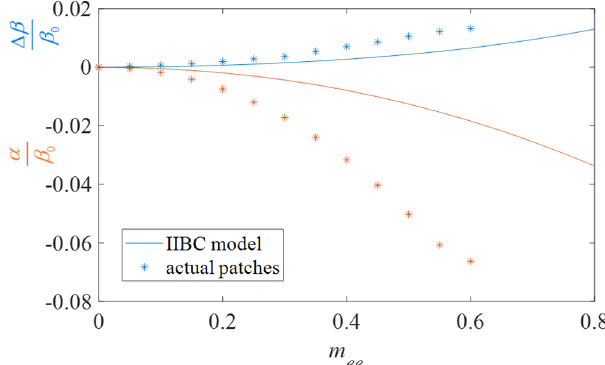
Fig. 5. Normalized real and imaginary part of the perturbation of the propagation constant on a modulated MTS. Comparison between IIBC model and rigorous full wave analysis for different values of the modulation